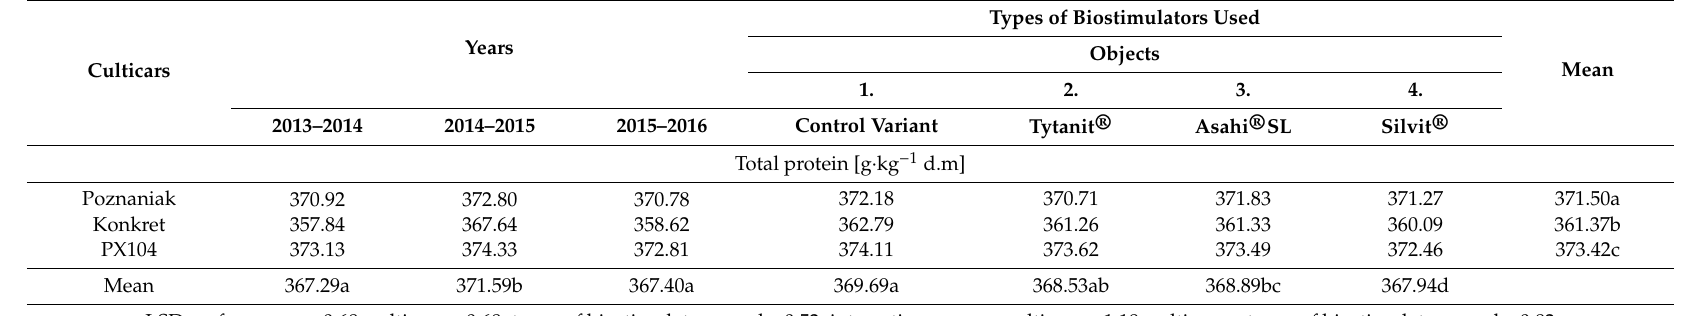
Table 2. Chemical composition of winter oilseed rapeseeds depending on factors of experience.